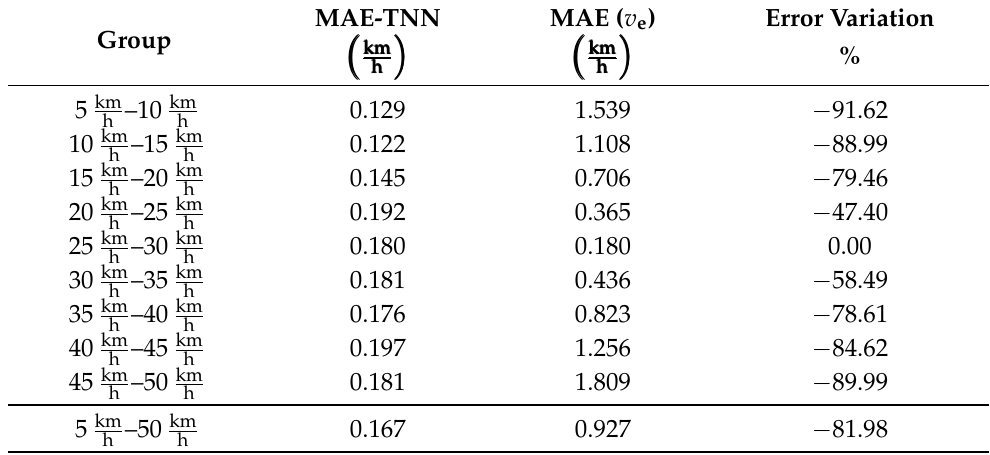
Table 8. MAE for v e vs. v r and the MAE for the inference of the TNN vs. v r . Database size: 603,828.